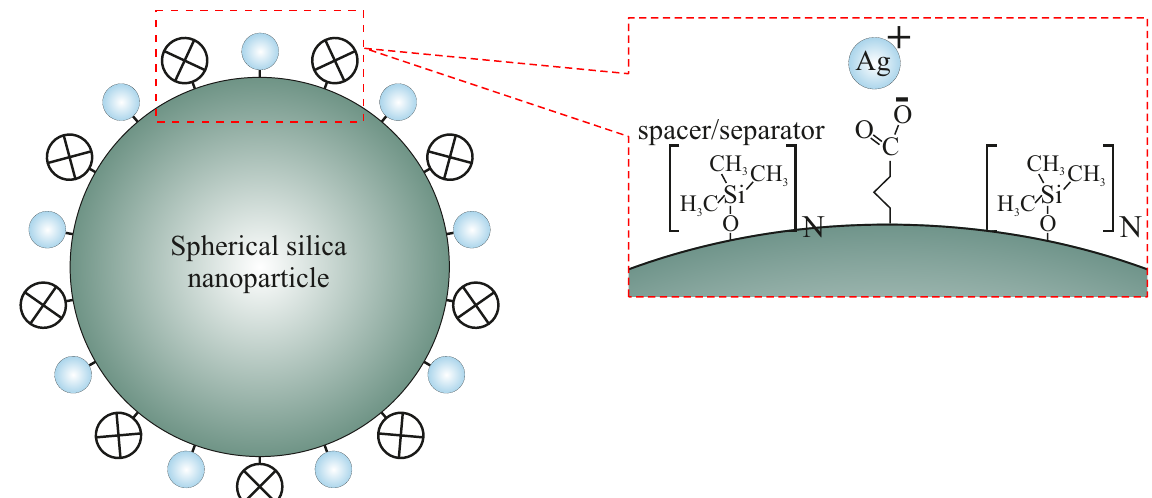
Figure 1. The scheme of spherical silica functionalized by silver ions with designed inter-molecular distances. The spacer units play the role of separators between silver-containing functional units. N denotes the statistical number of spacer units between